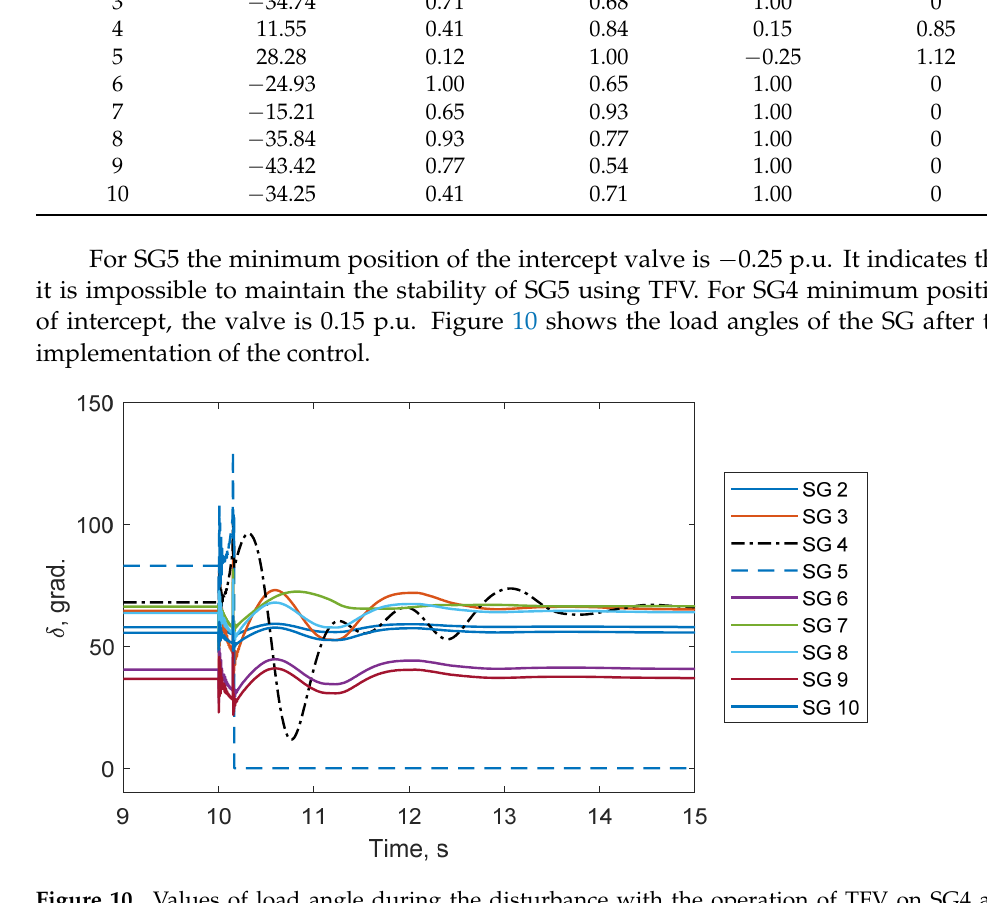
Figure 10. Values of load angle during the disturbance with the operation of TFV on SG4 and disconnection of the SG5 being considered.